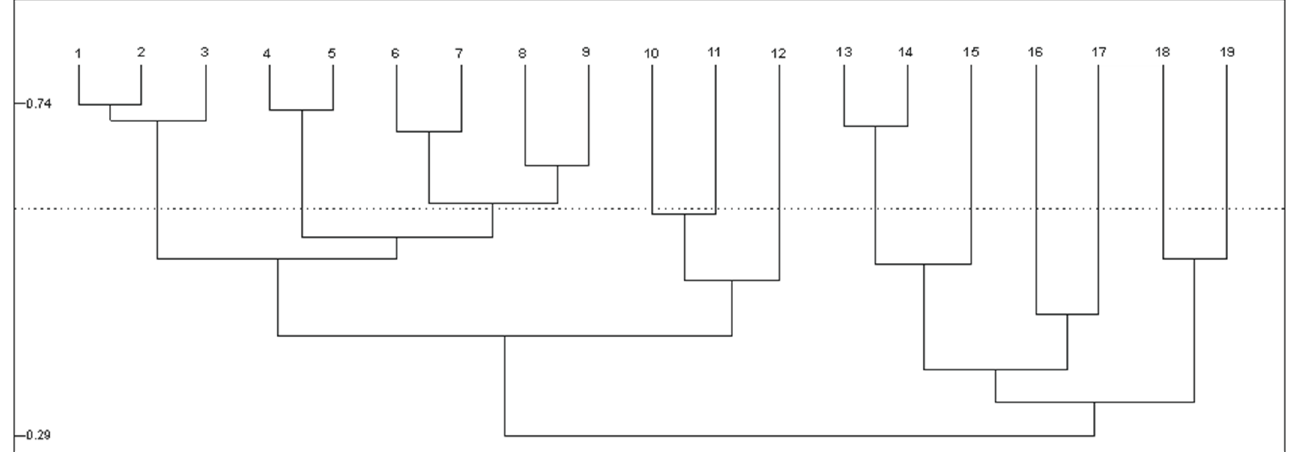
Figure 3. Species similarity of Uropodina communities inhabiting dead wood of different tree species: 1—maple, 2—oak, 3—black alder, 4—spruce, 5—sycamore, 6—pine, 7—birch, 8—linden, 9—beech, 10—horse-chestnut, 11—elm, 12—hornbeam, 13—larch, 14—aspen, 15—fir, 16—yew, 17—poplar, 18—willow, 19—ash. Dotted line—50%